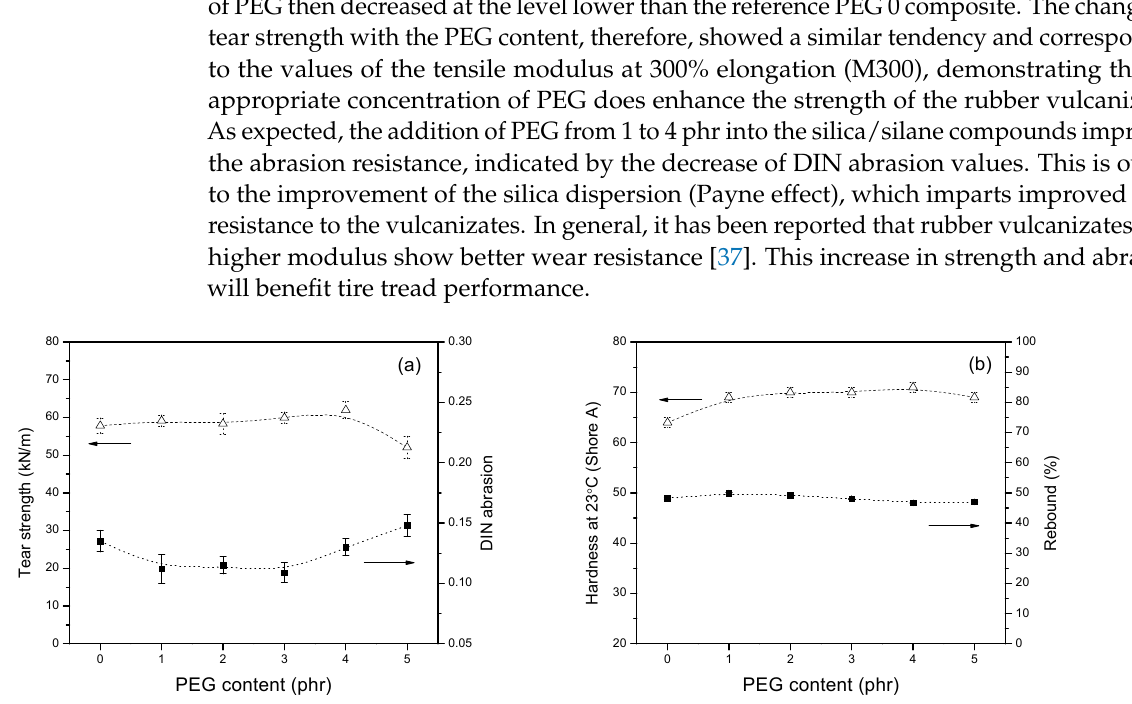
Figure 10. Effect of PEG contents on ( a ) tear strength and DIN abrasion and ( b ) hardness and rebound of silica/silane compounds.